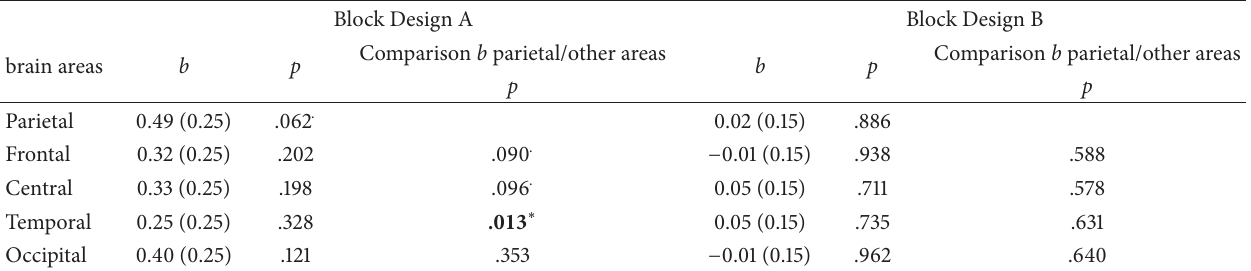
Table 5: Correlation between alpha/theta ratio and Block Design Test.